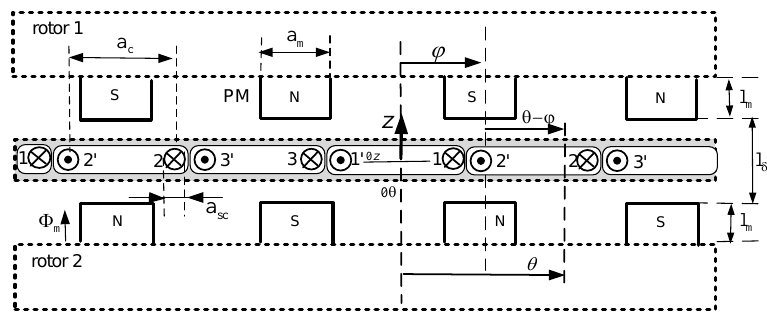
Figure 11. Cross section of coreless AFPMG construction.